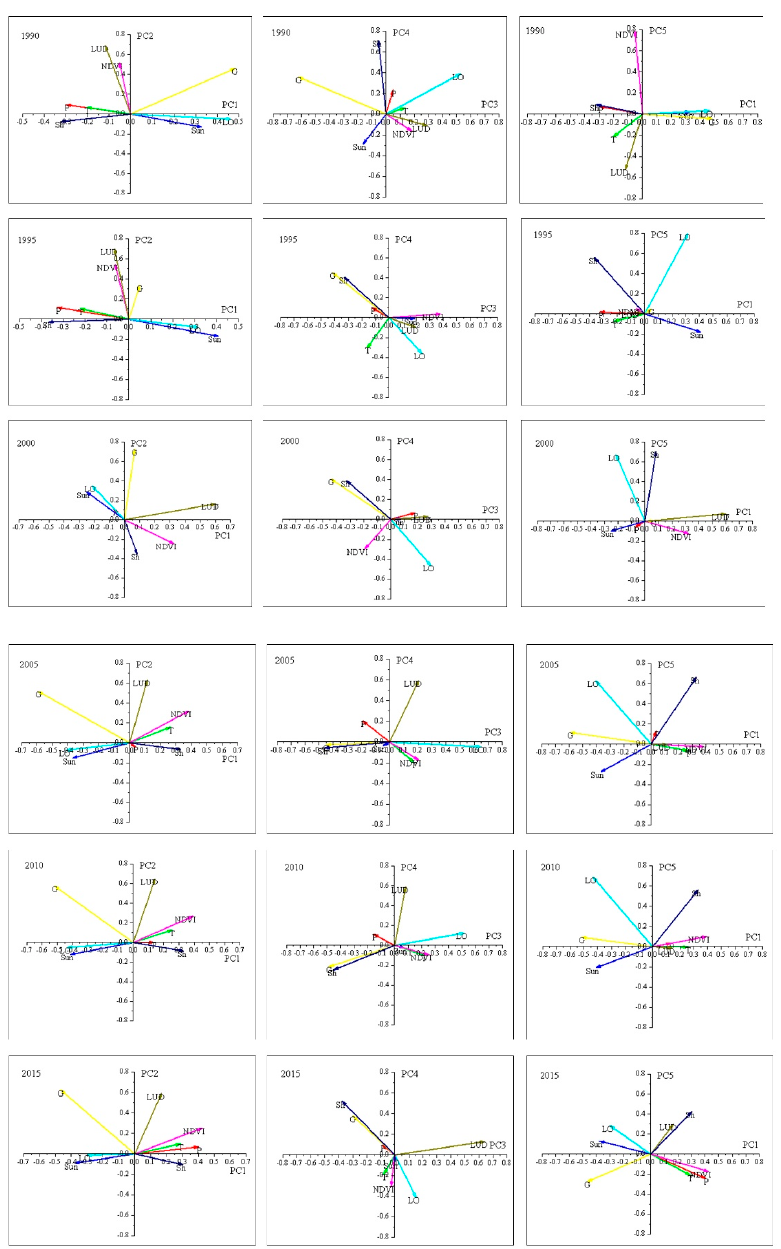
Figure 7. Correlation analysis between principal components 1–5 and various indicators. (P—average annual precipitation; T—average annual temperature; Sun—hours of sunshine; POP—population density; LO—livestock husbandry output; S—slope; NDVI; GDP; G—grassland area; PPA—plateau permafrost area; W—wind speed; SRD—surface relief degree; SRI—solar radiation intensity; LUD—land use degree; DA—desertification area; Sh—Shannon index; RH—relative humidity; WRA—water resources